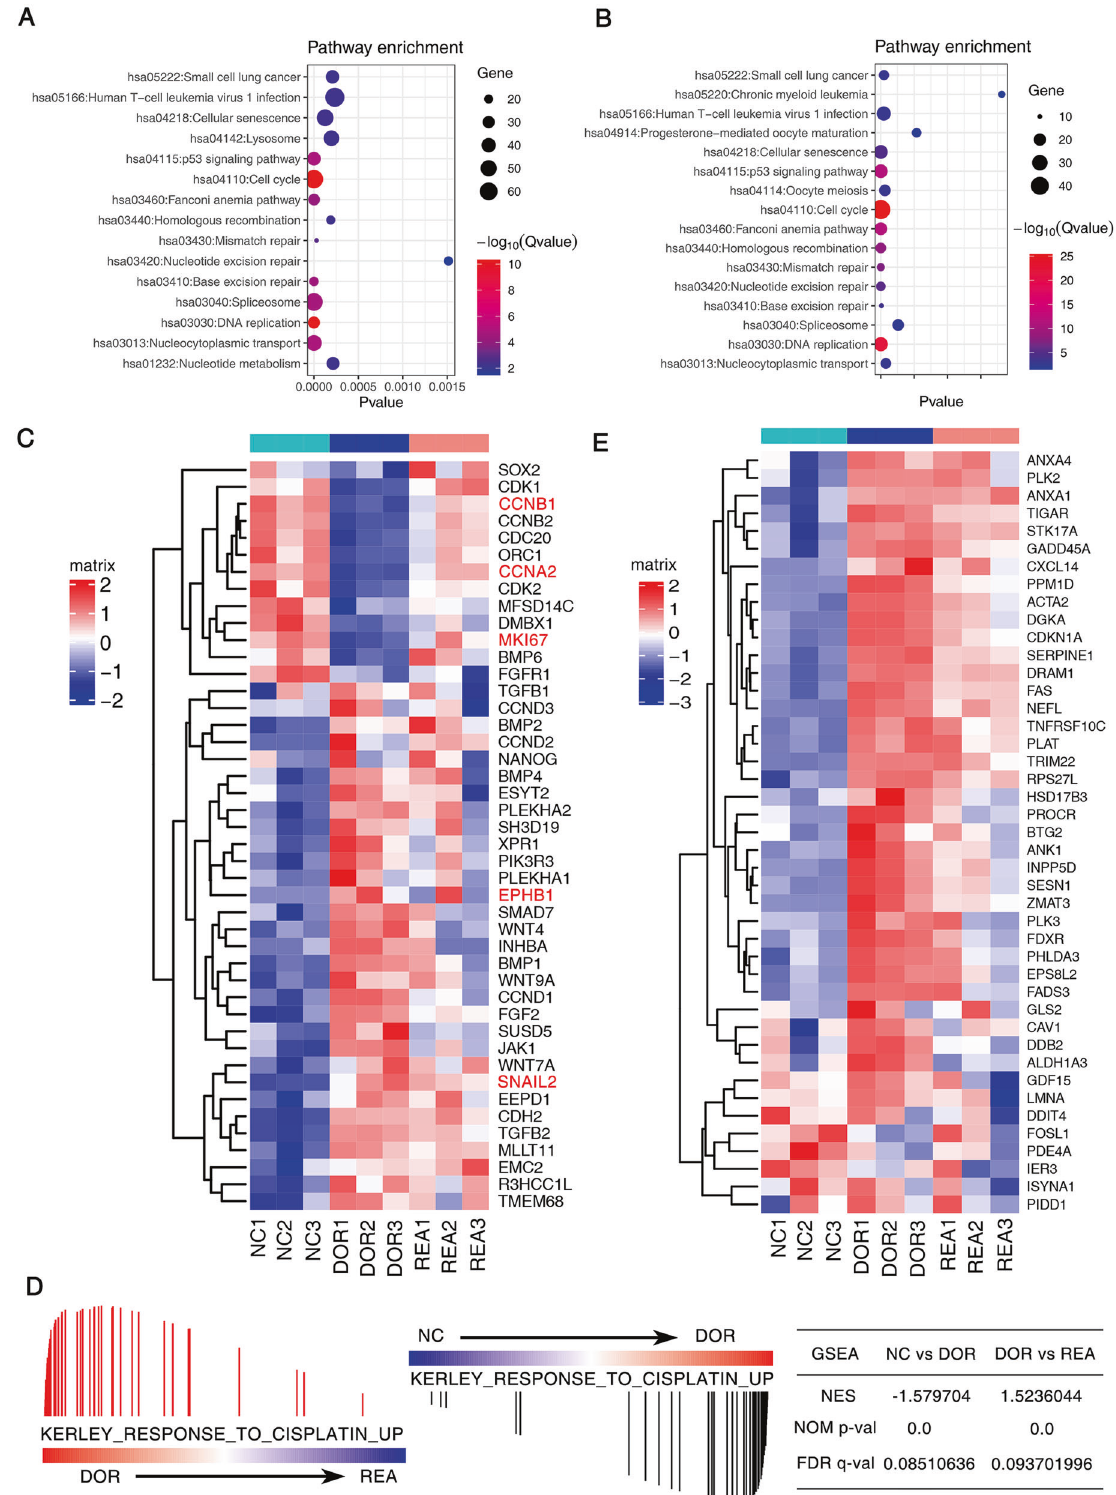
Fig. 2 Cisplatin-induced dormant and reactivated lung cancer cells show distinct gene expression pro fi les. The differential gene expression pro fi les were evaluated by RNA-seq. The DEGs were subjected to KEGG pathway enrichment analysis between dormant cancer cells and untreated cancer cells ( A ); between reactivated cancer cells and dormant cancer cells ( B ); C The heatmap of the expression of signi fi cant genes in cell cycle, EMT et al. between 3 cell phases induced by cisplatin; D GSEA analysis of differentially expressed genes. Gene set enrichment analysis using “ GSEA, KERLEY_RESPONSE_TO_CISPLATIN_UP ” was performed. P value < 0.001. The NES and FDR were shown. E The heatmap of the expression of signi fi cant genes in cisplatin-resistance between 3 cell phases induced by cisplatin.